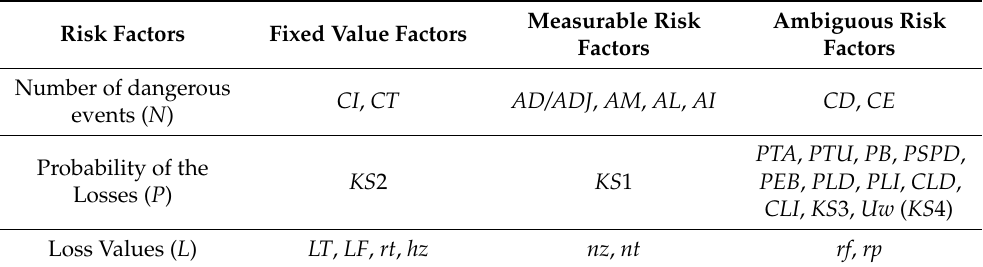
Table 9. Risk Factors Characteristics.